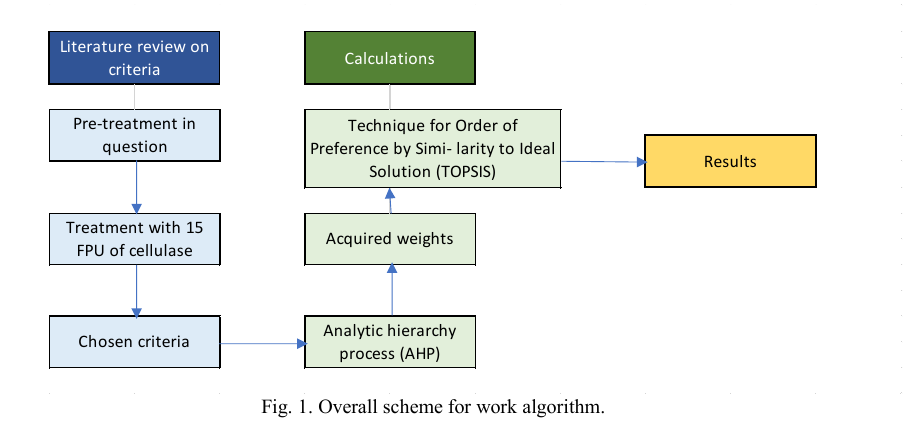
Fig. 1. Overall scheme for work